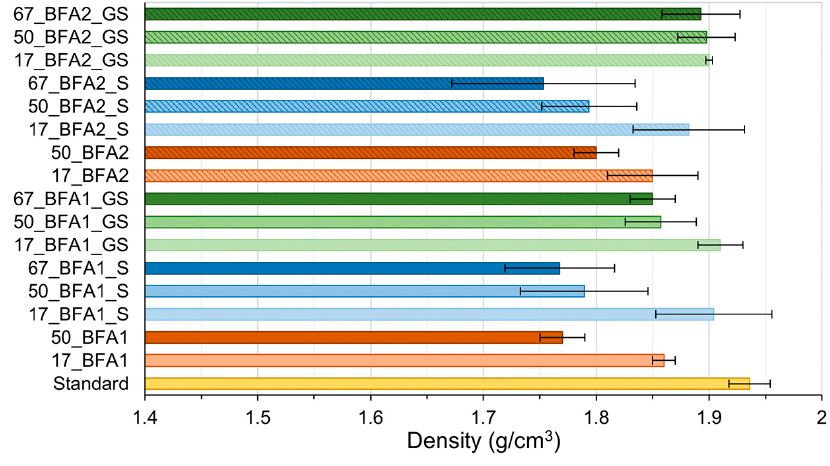
Figure 4. Density of the mortars prepared with BFA1 and BFA2 after curing for 28 days.